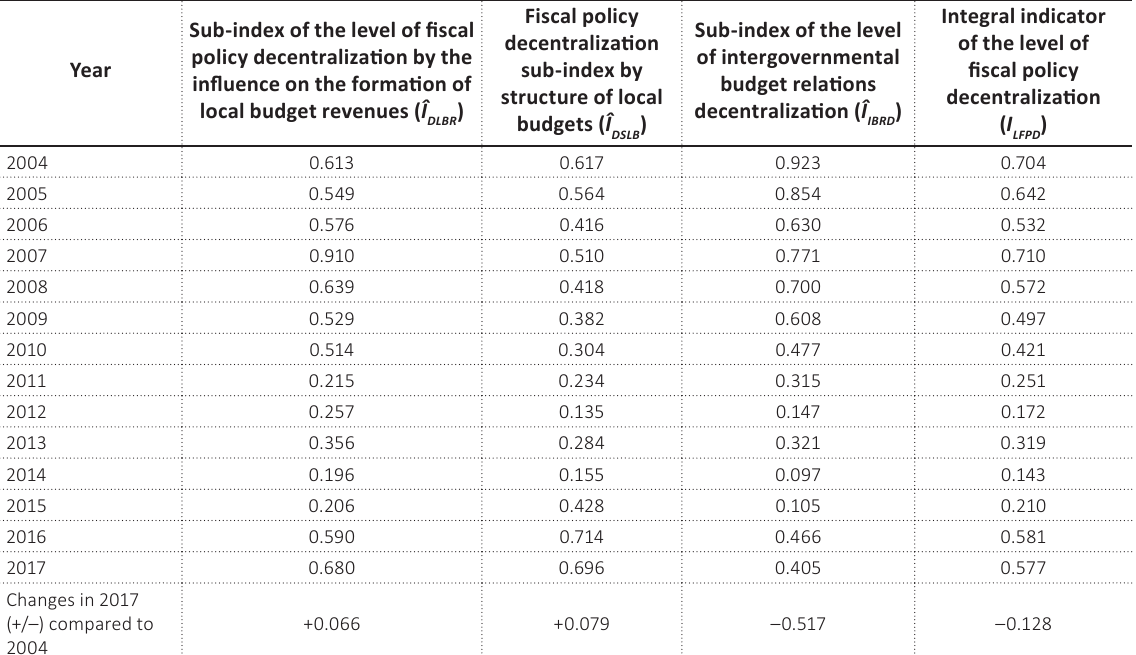
Table 15. Calculation of the integral indicator of the level of fiscal policy decentralization for the